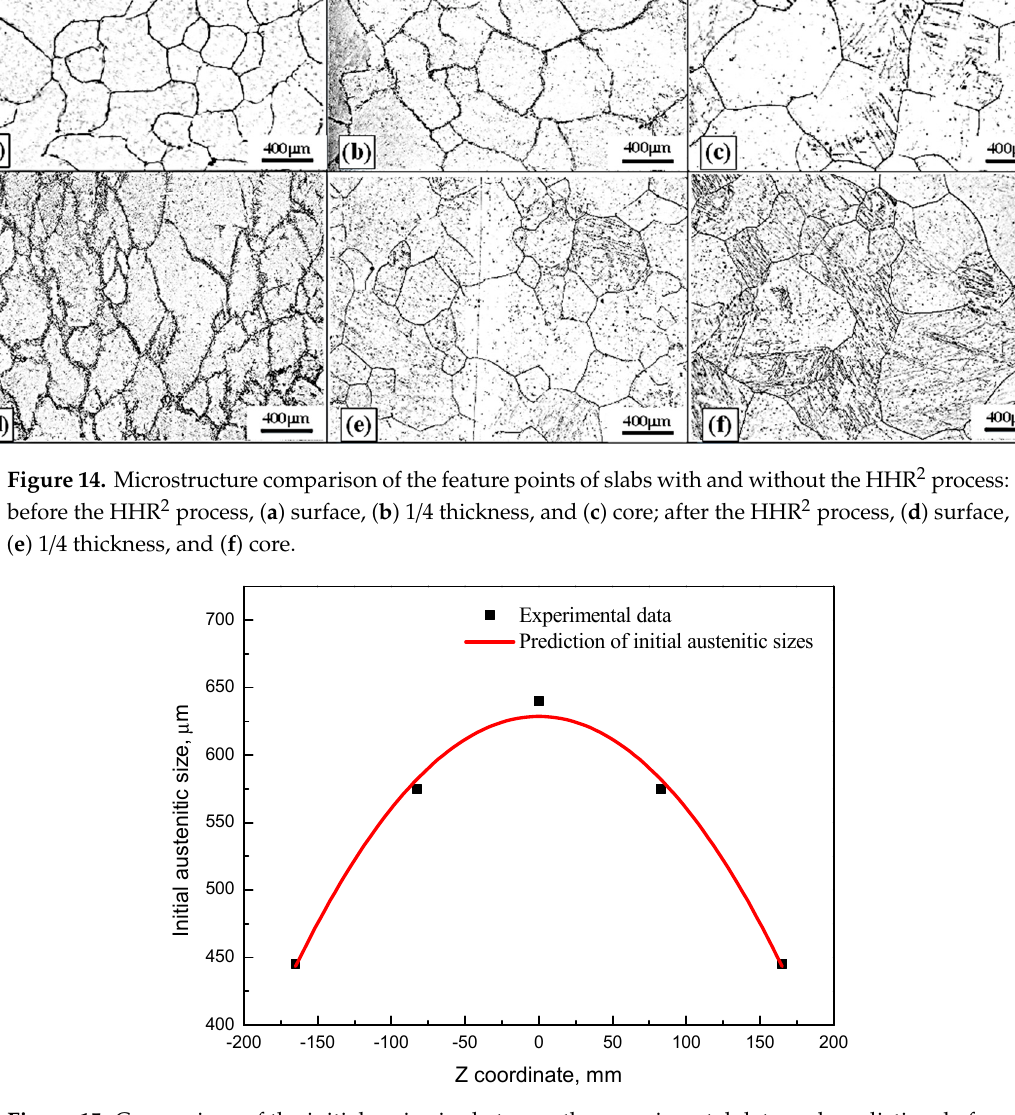
Figure 15. Comparison of the initial grain size between the experimental data and prediction, before the HHR 2 process.